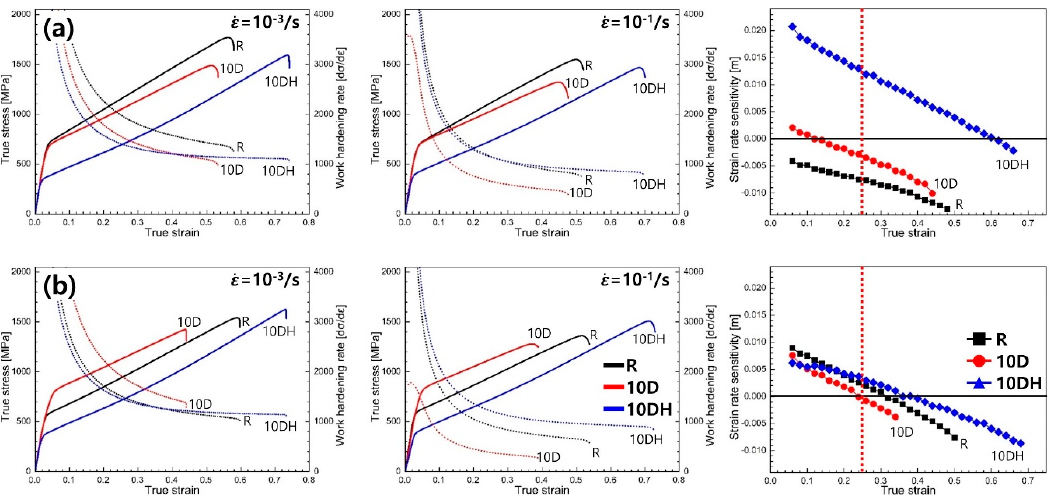
Figure 9. True stress–strain curves and strain rate sensitivity of the ( a ) base metal and ( b ) weld metal. Strain rate sensitivity parameters were calculated from the true stress–strain curves (strain rate of 10 – 3 and 10 –1 /s).